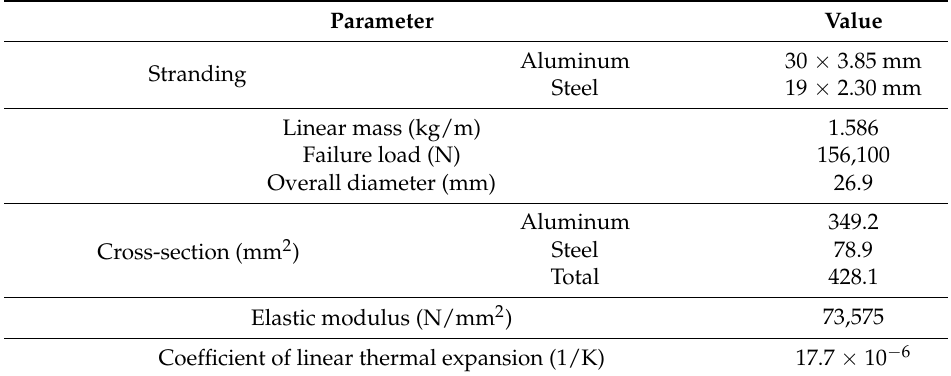
Table 2. Bare wire mechanical characteristics (wire type